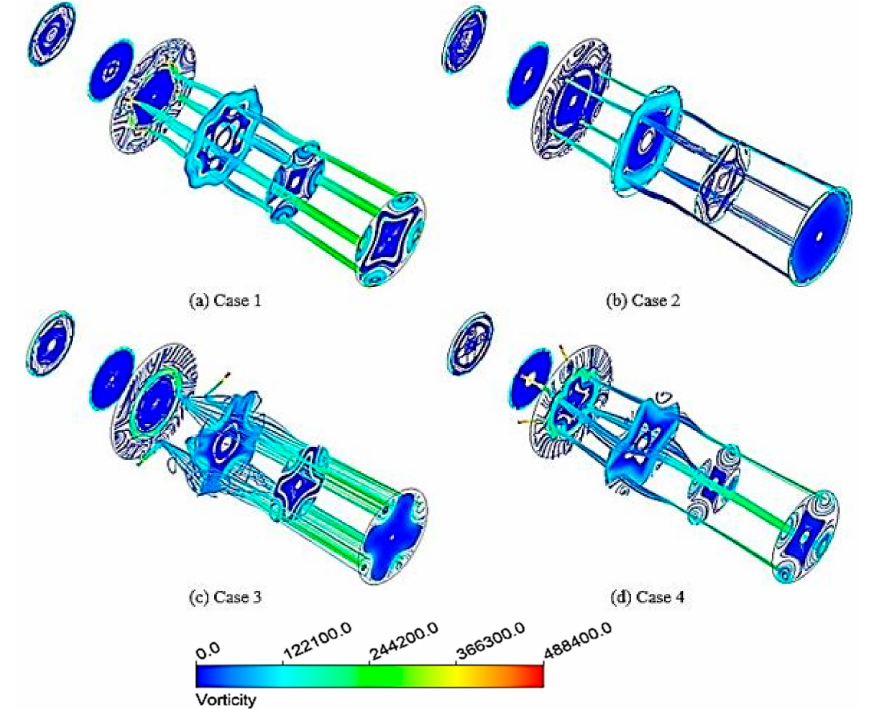
Figure 6. Vorticity contour at the various axial length of the